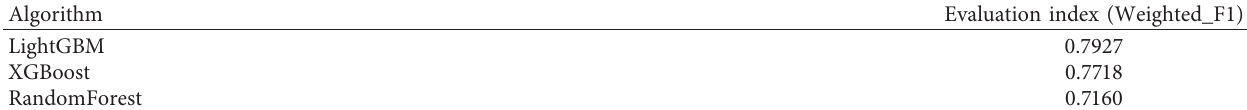
Table 3: The accuracy of LightGBM, XGBoost, and RandomForest forecast classification. Algorithm